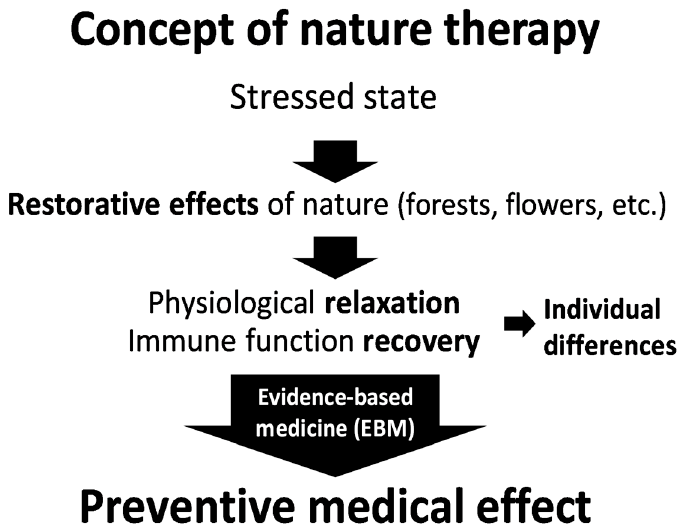
Figure 1. Concept of nature therapy [9]. Permission to publish from Yoshifumi Miyasaki.